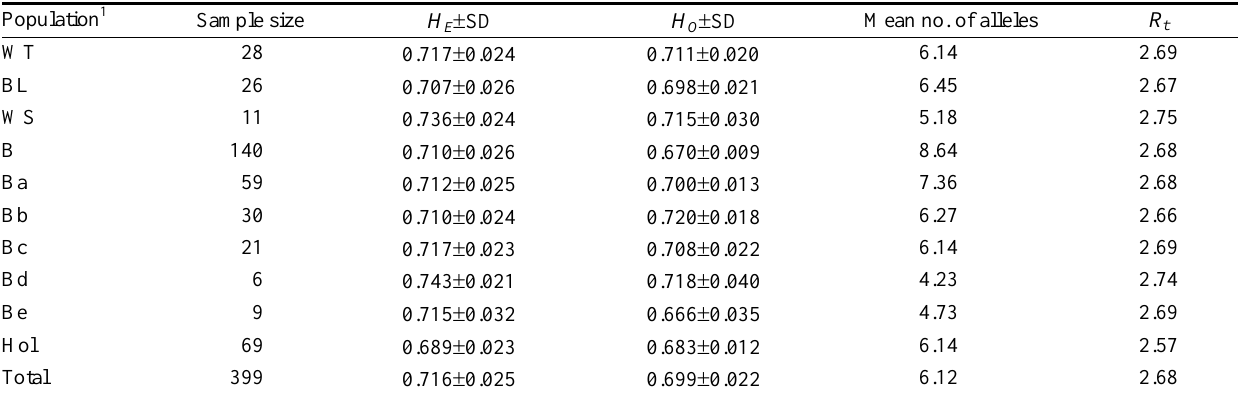
1 WT = White coat mixed with brown, BL = Black coat mixed with brown, WS = White spotted coat separated with brown, B = Hanwoo cattle with a cuticolor nose and pure brown coat, B (a to e): B (a to e): a-e represent different degree of nose pigmentation with “a” being the lightest and “e” the darkest, Hol = Holstein animals utilized as dairy cattle in